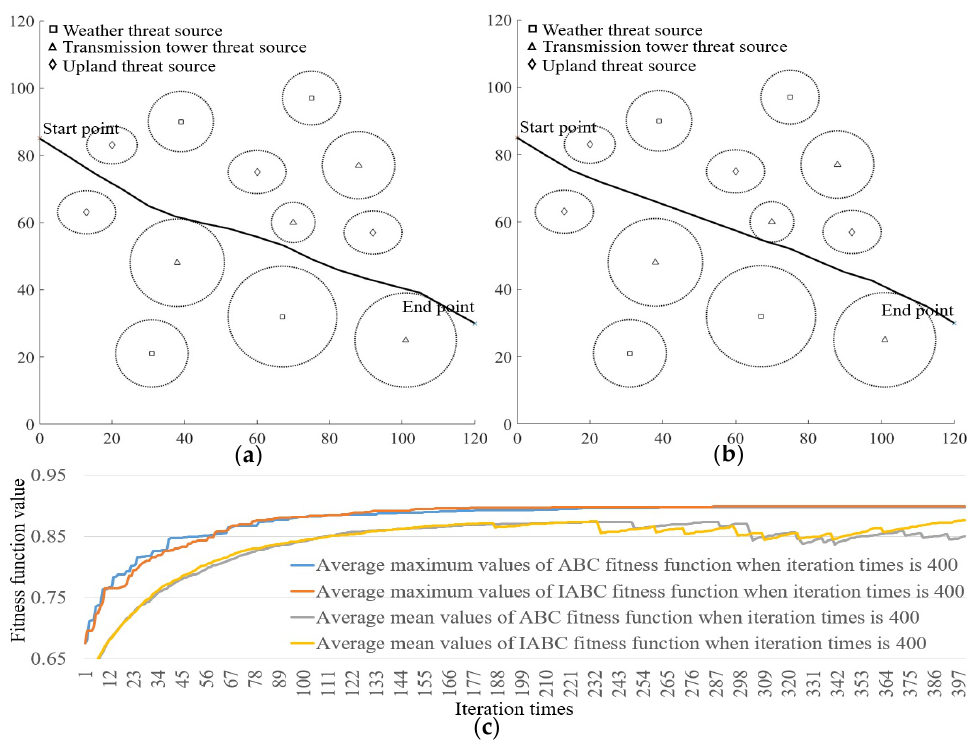
Figure 10. Examples of path planning and statistical results of fitness function using 400 iterations. ( a , b ) Path planning examples of ABC and IABC when iteration times is 400. ( c ) Statistical results of fitness function of ABC and IABC when iteration times is 400.